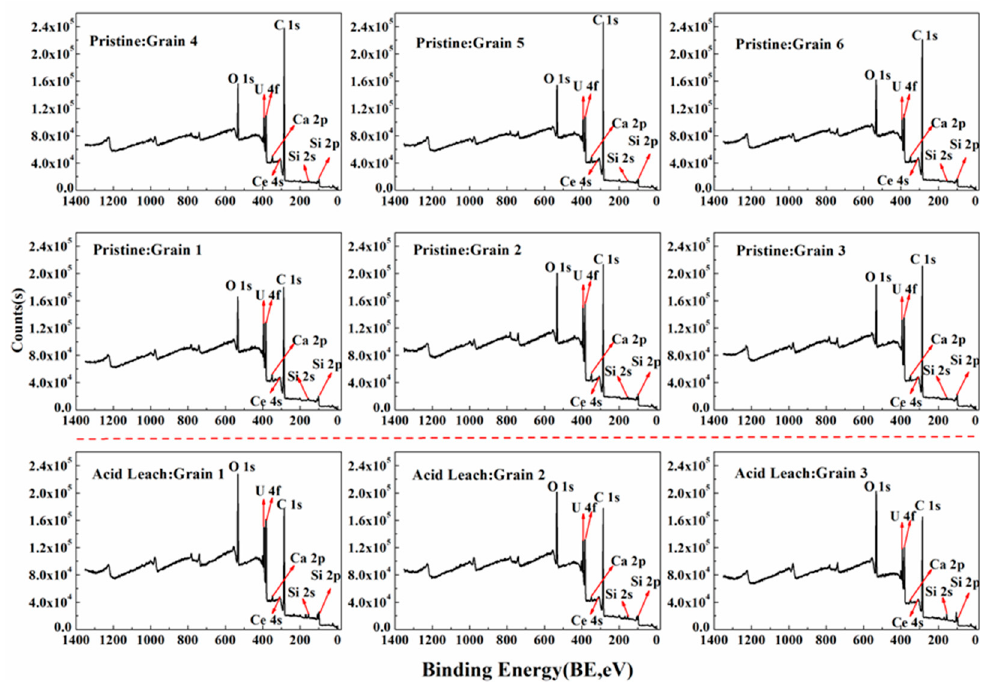
Figure 8. Survey XPS scan of the uraninite in the MHK uranium deposit. Above the red dotted line: pristine samples; below the red dotted line: samples leached by sulfuric acid). The red arrows pointed to the names of elements peak.